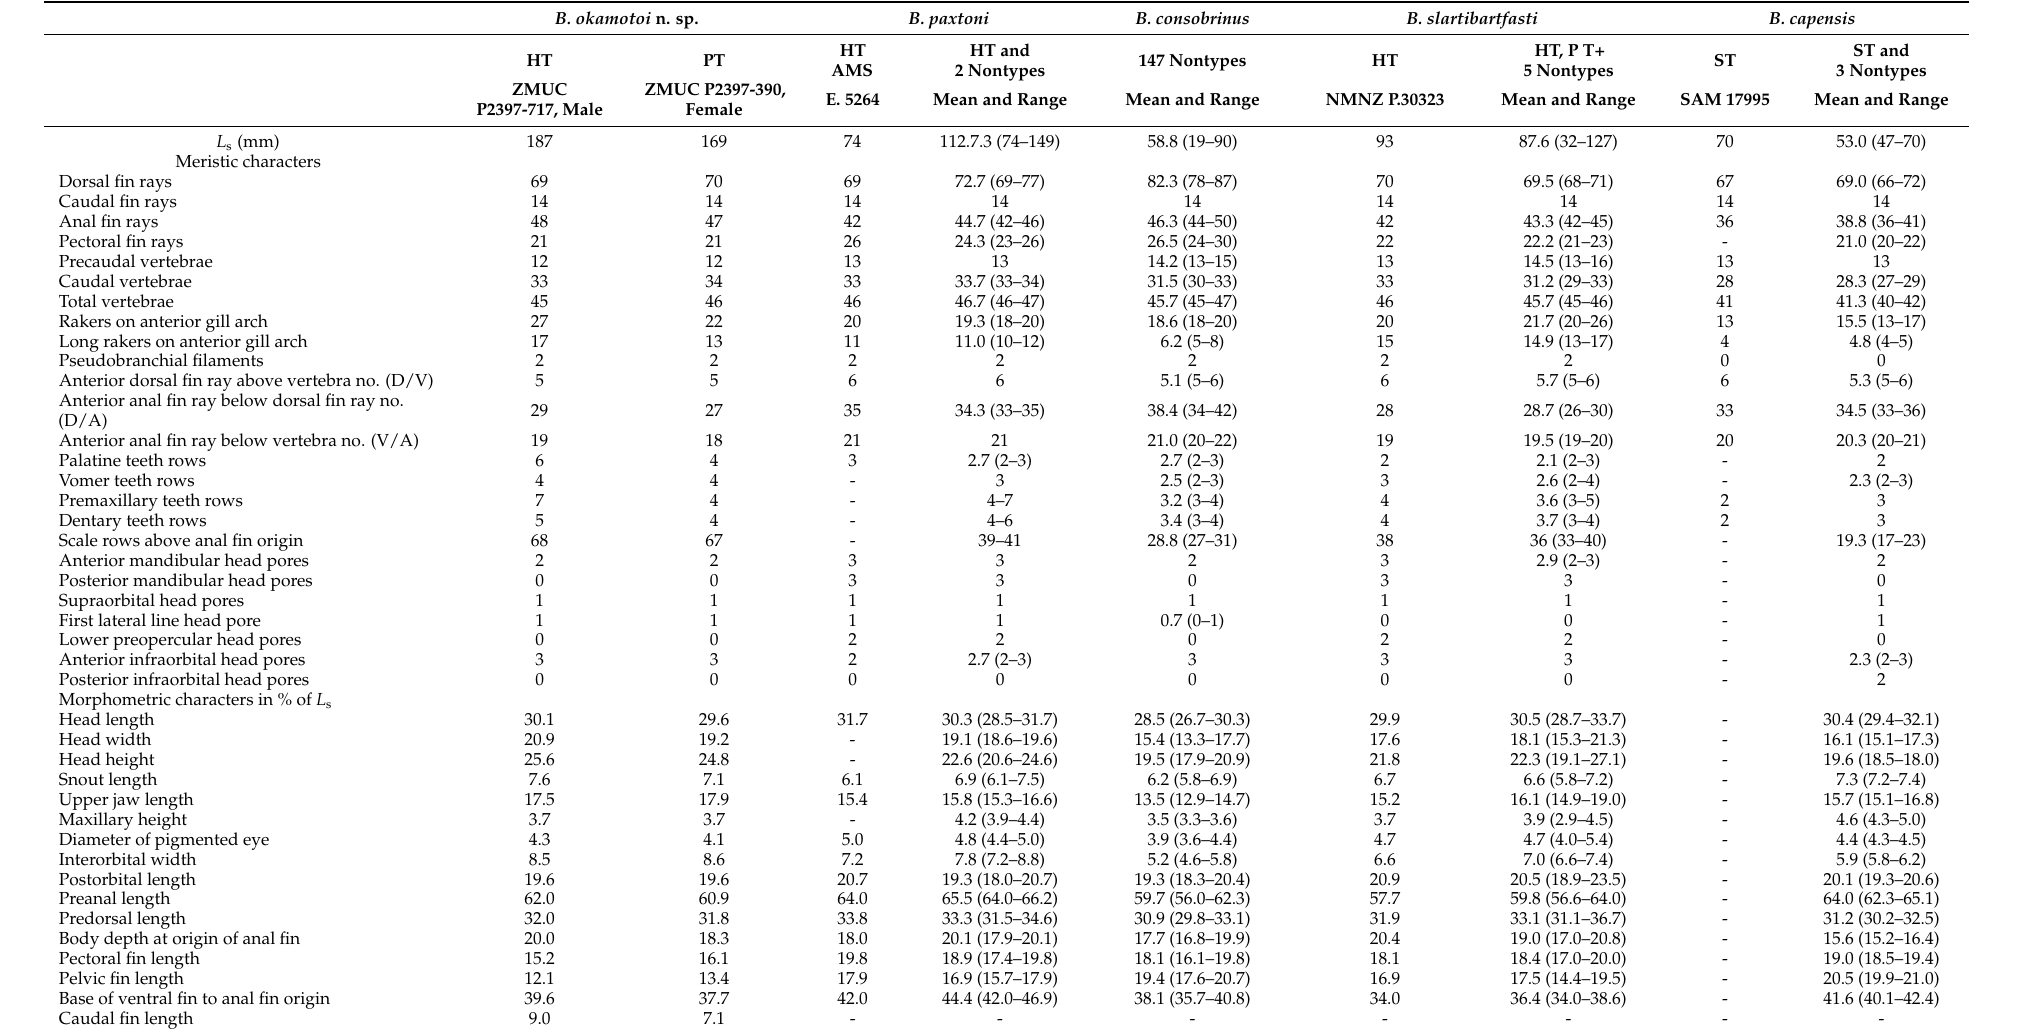
Table 1. Meristic and morphometric characters of Bidenichthys